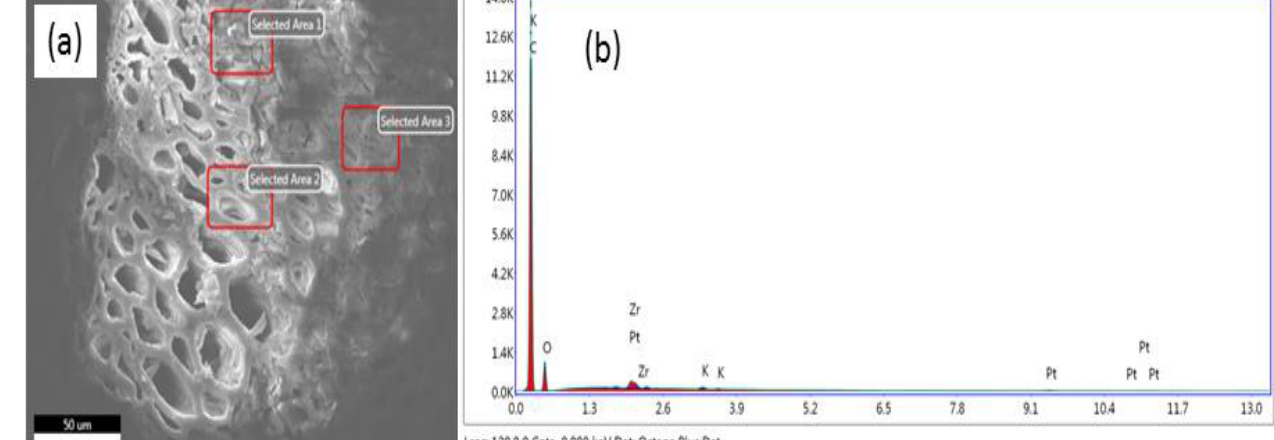
Figure 5. ( a ) SEM micrograph of biochar and ( b ) EDX graph of biochar after arsenic adsorption at optimized conditions.